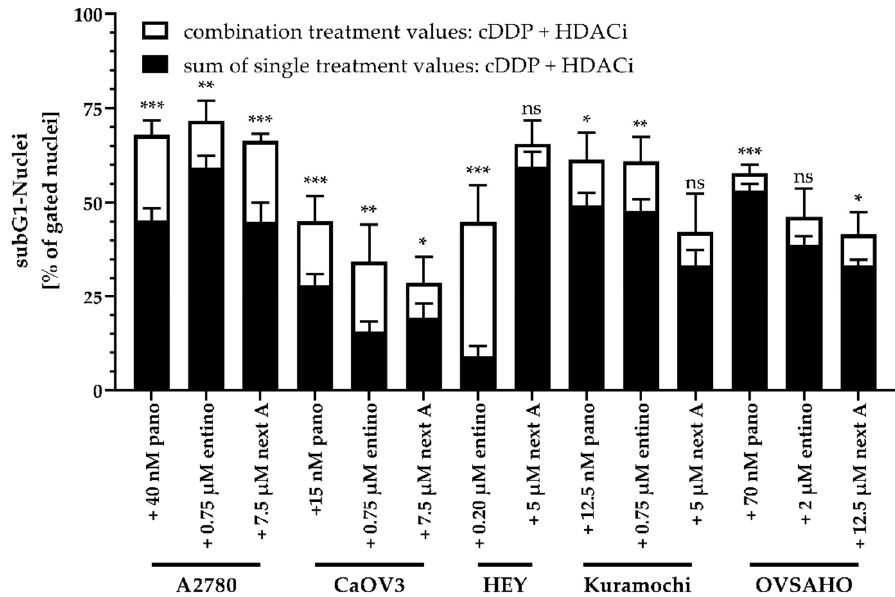
Figure 5. Synergistic effects of the combination of HDACi and cisplatin on apoptosis induction. The sum of single treatment effects (HDACi, cisplatin) are shown in black bars. The extended white bars show the difference (superadditive (= synergistic) part) between the sum of single treatment effects and the effect of combination treatments. Vehicle treated control was subtracted. Data are the mean ± SD. Statistical analysis was performed using t-test. Levels of significance: ns ( p > 0.05); * ( p ≤ 0.05); ** ( p ≤ 0.01); *** ( p ≤ 0.001).